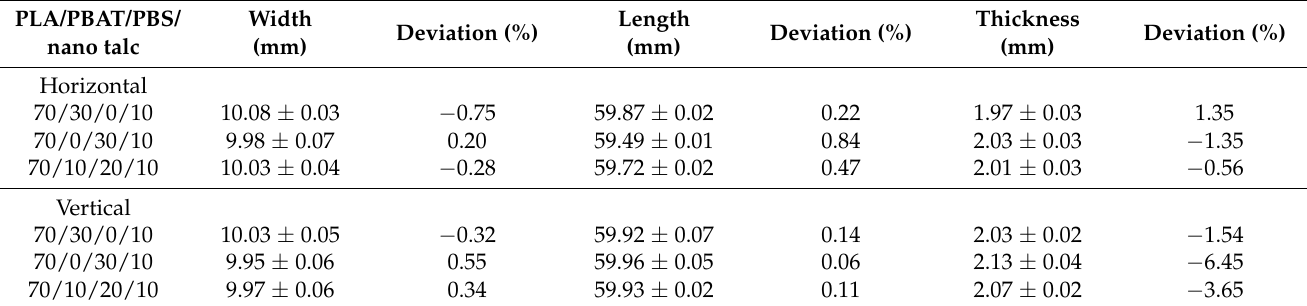
Figure 10. ( a ) Schematic of the vertical 3D printing line; ( b ) SEM image from the thickness side of 70/0/30/10 3D printing. Table 9. Dimensional accuracy of PLA/PBAT/PBS/nano talc composites 3D prints.